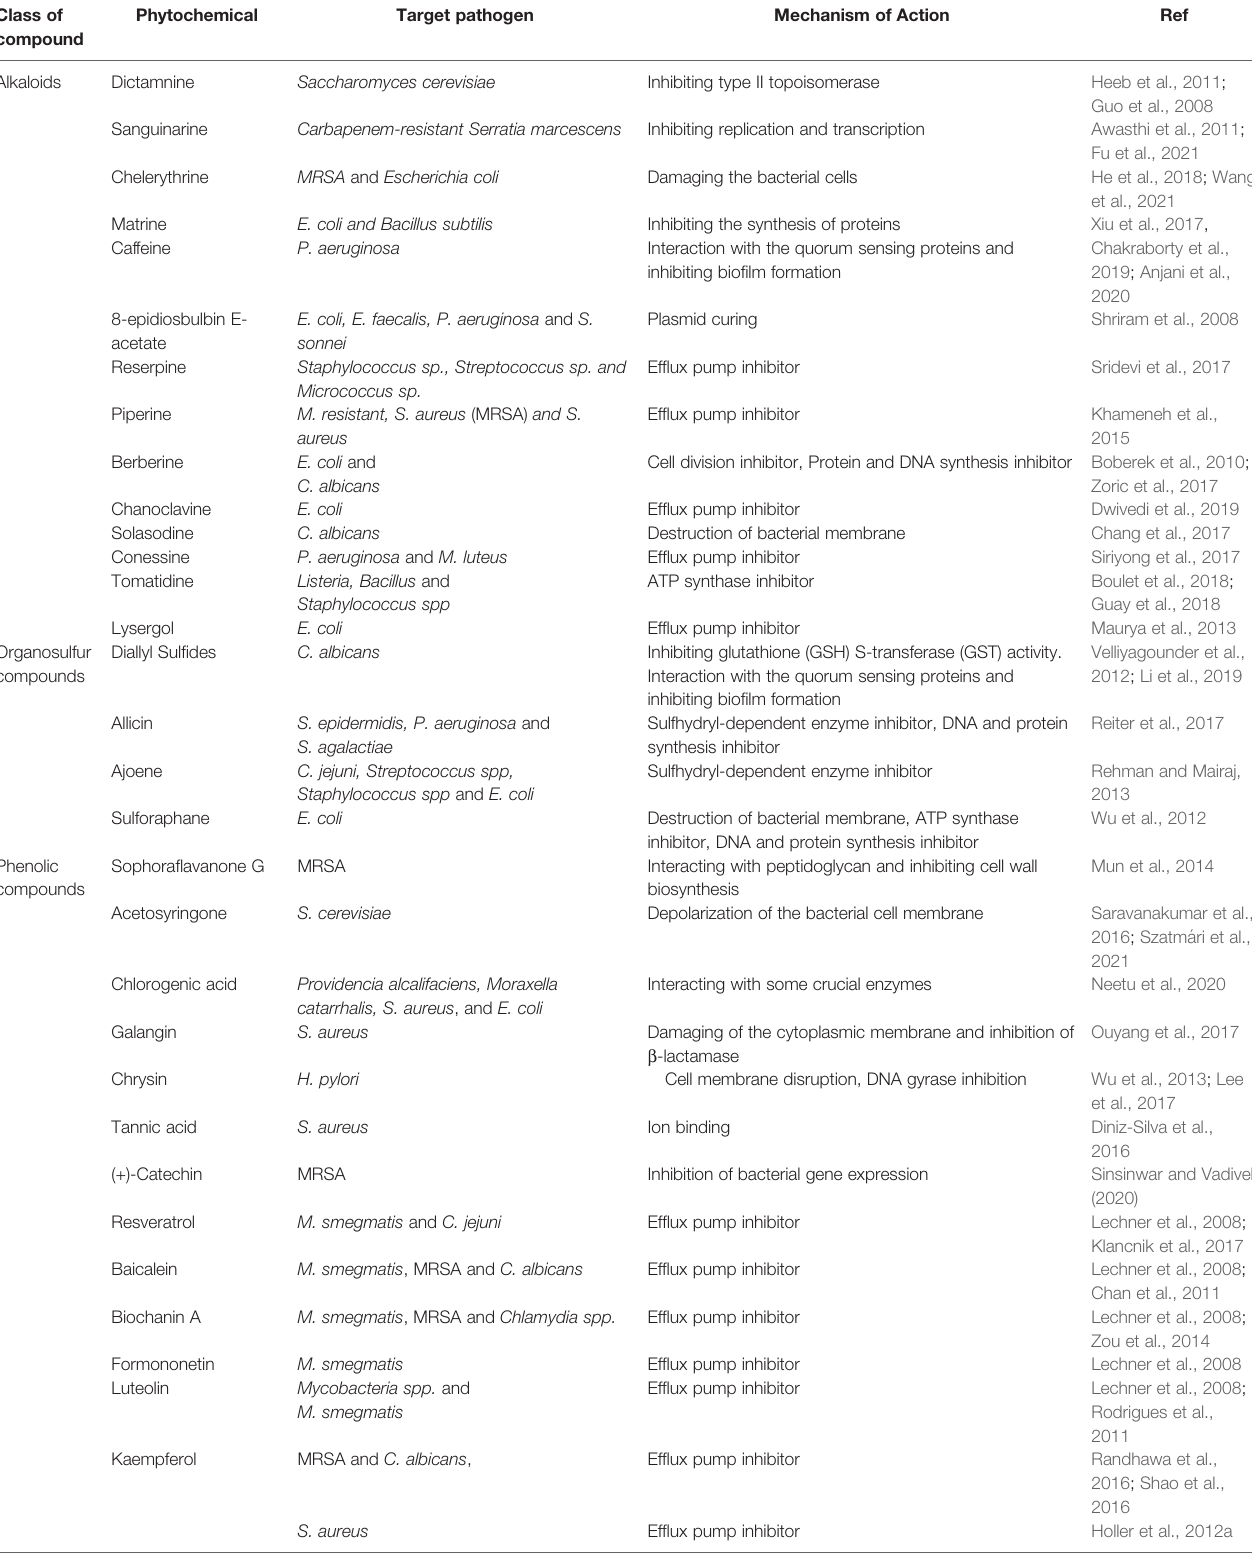
TABLE 1 | Plant based antimicrobial compounds and their mechanism of